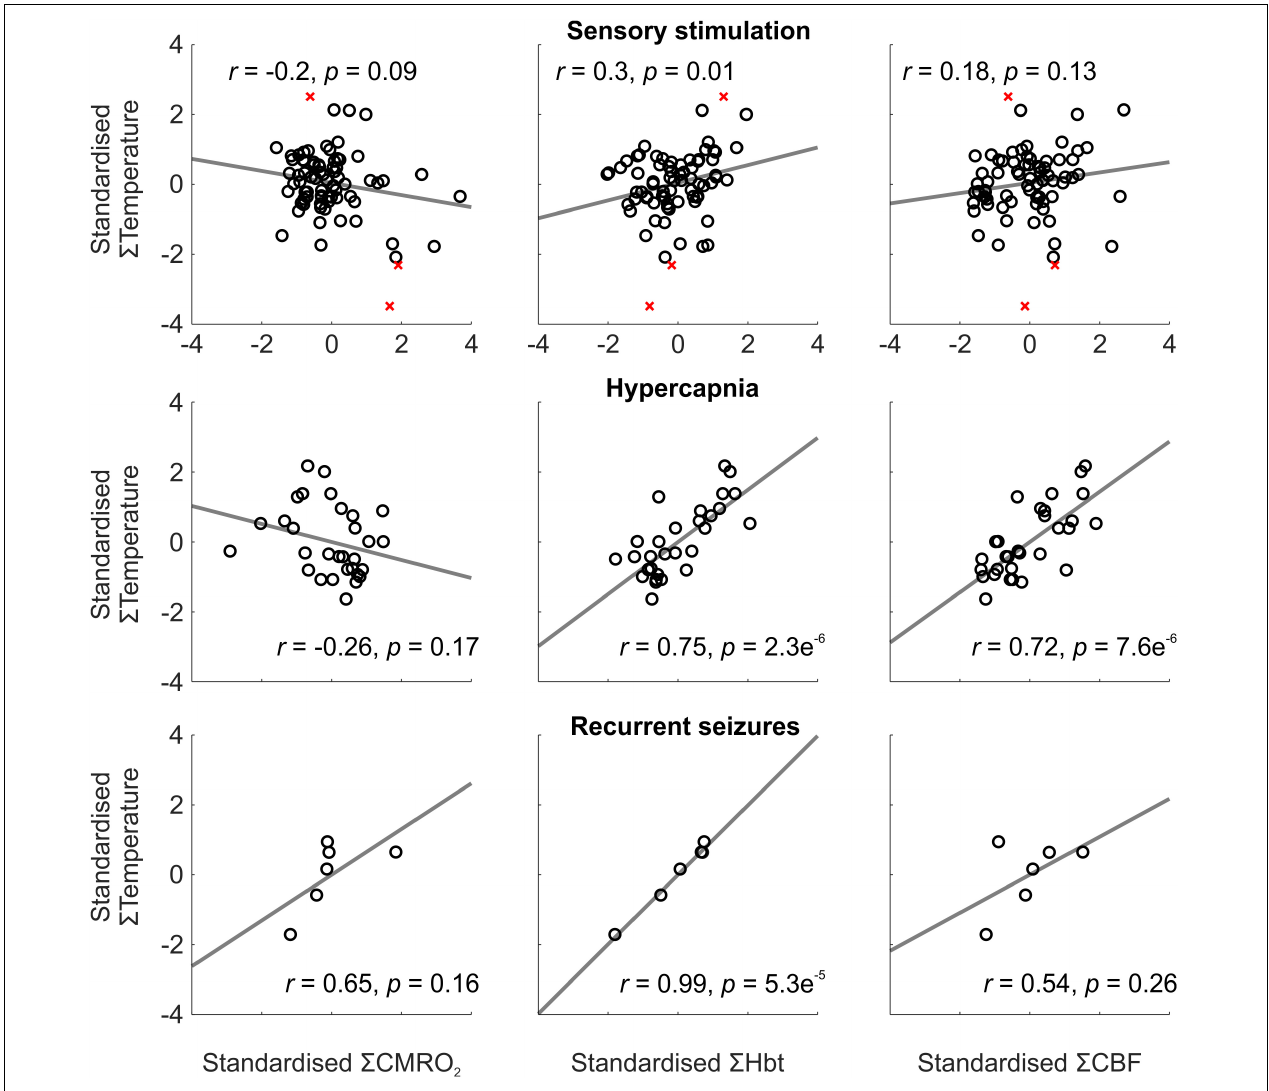
FIGURE 2 | Relationship between temperature and CMRO 2 , Hbt, and CBF during a range of brain activation types. Trial-by-trial analysis of coupling between standardized CMRO 2 (Left), Hbt (Middle) and CBF (Right), and temperature, during sensory stimulation (Top, N = 72), pooled hypercapnia (Middle, N = 30), and recurrent seizures (Top, N = 6). Disregarded outliers in sensory stimulation condition marked as red crosses ( N = 3). Linear functions (gray) fitted using least squares regression with Pearson correlation coefficients and significance given as